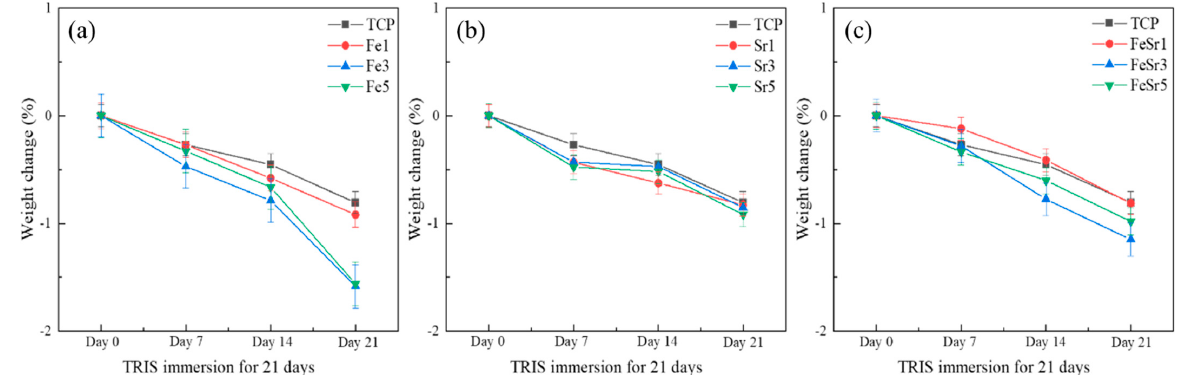
Figure 11. Weight change (%) after immersion in TRIS − HCl solution for 7, 14, and 21 days: ( a ) Fe − substituted samples, ( b ) Sr − substituted samples, ( c ) Fe/Sr co − substituted samples.